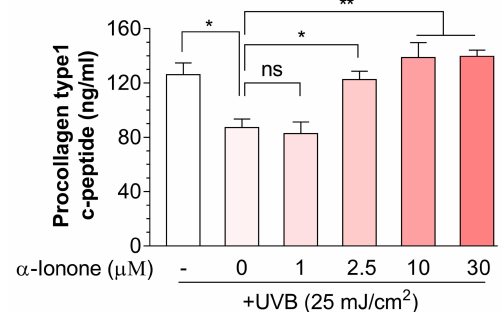
Figure 2. α -Ionone increases collagen contents in human Hs68 dermal fibroblasts. Values are presented as means ± SEM (n = 3). Significant di ff erences between groups are indicated by asterisks: * P < 0.05; ** P < 0.01; ns, not significant ( P > 0.05).